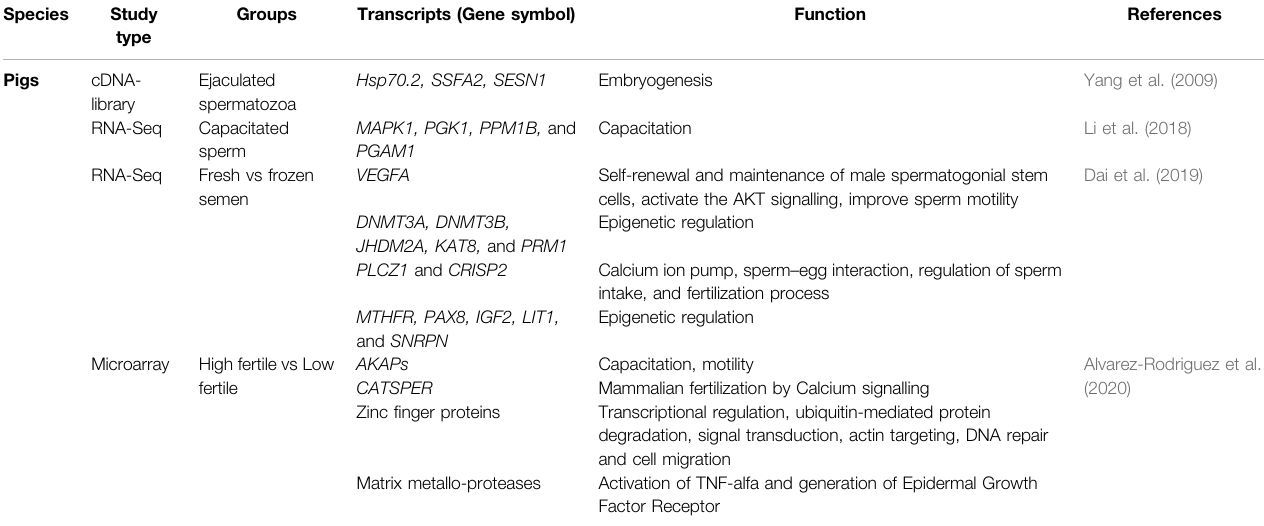
TABLE 2 | Important protein coding transcripts reported in pig spermatozoa by transcriptome analysis.